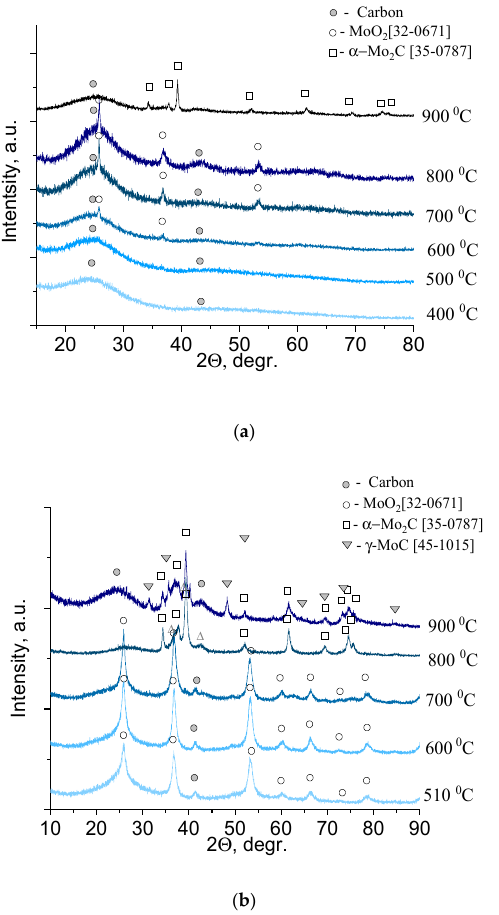
Figure 4. XRD pattern of molybdenum blue xerogels synthesized using ( a ) glucose (G-4, R/Mo = 4.0) and ( b ) hydroquinone (H-4, R/Mo = 4.0), calcined at different temperatures in an inert N 2